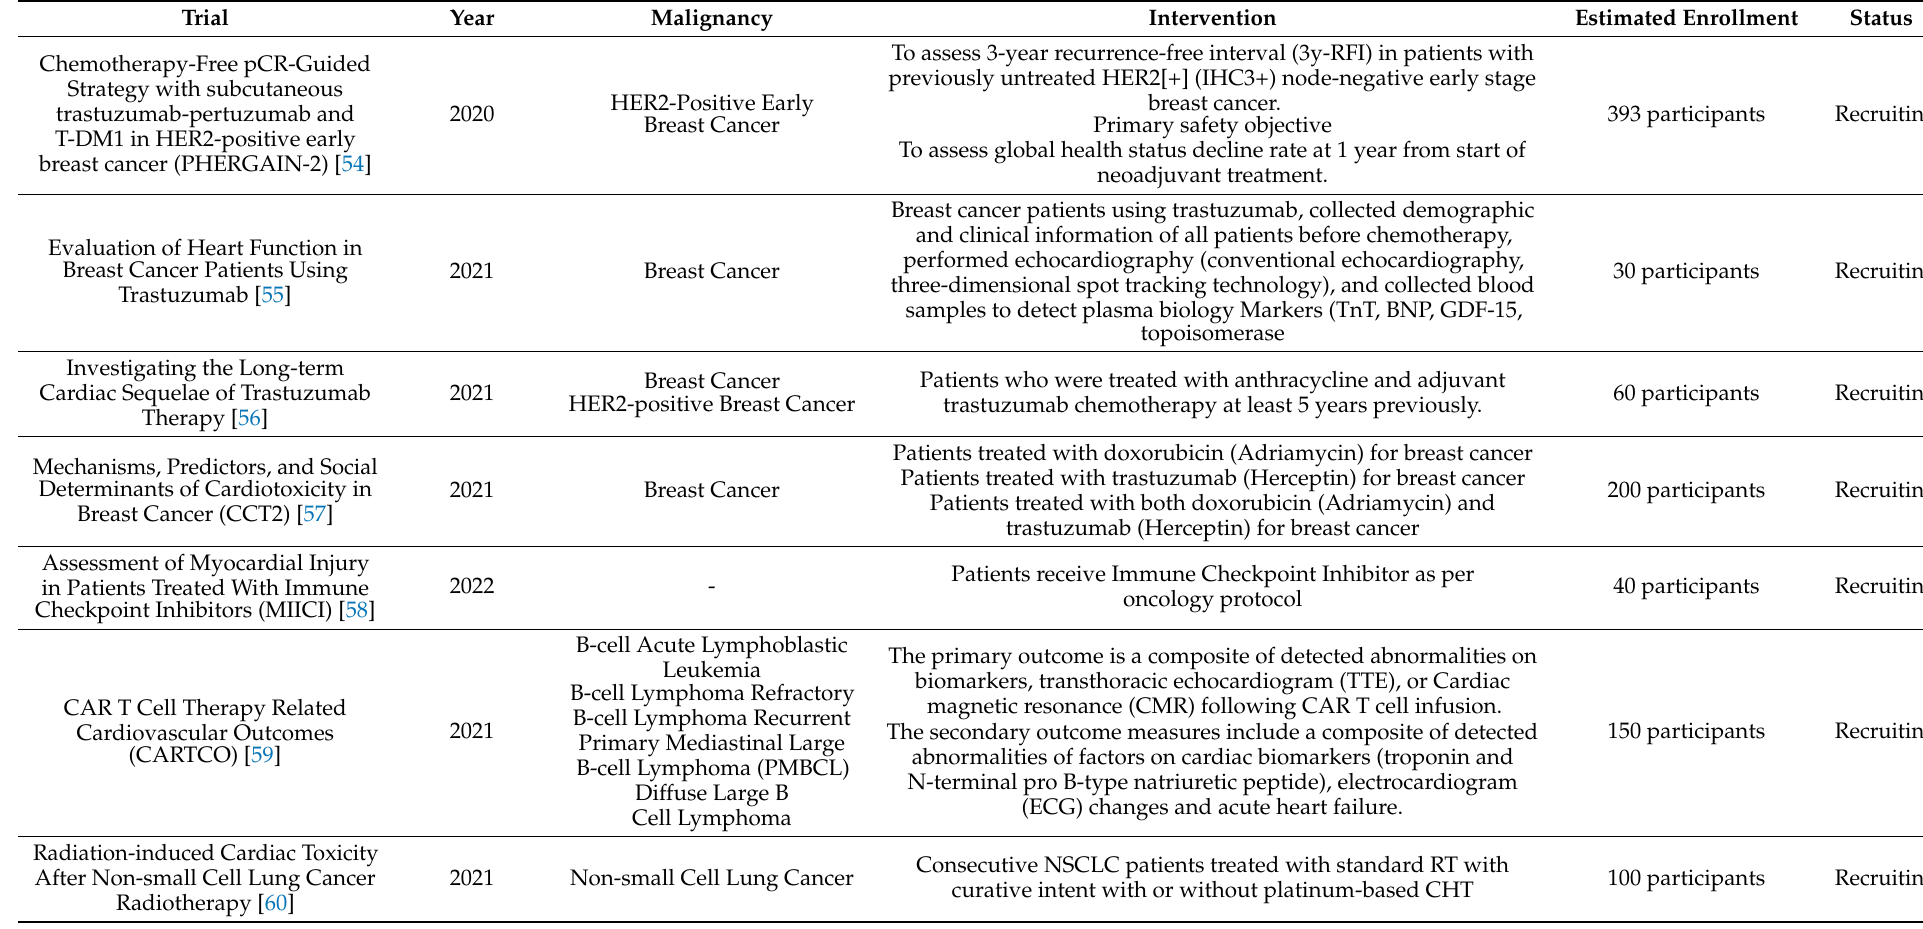
Table 2. Ongoing Trials on anticancer treatments and cardioprotecion as 2021 and later.